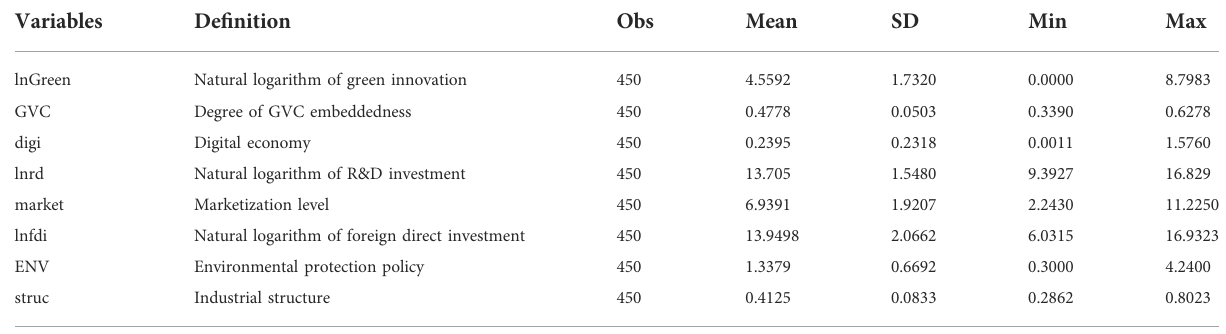
TABLE 2 Descriptive statistics of main variables.